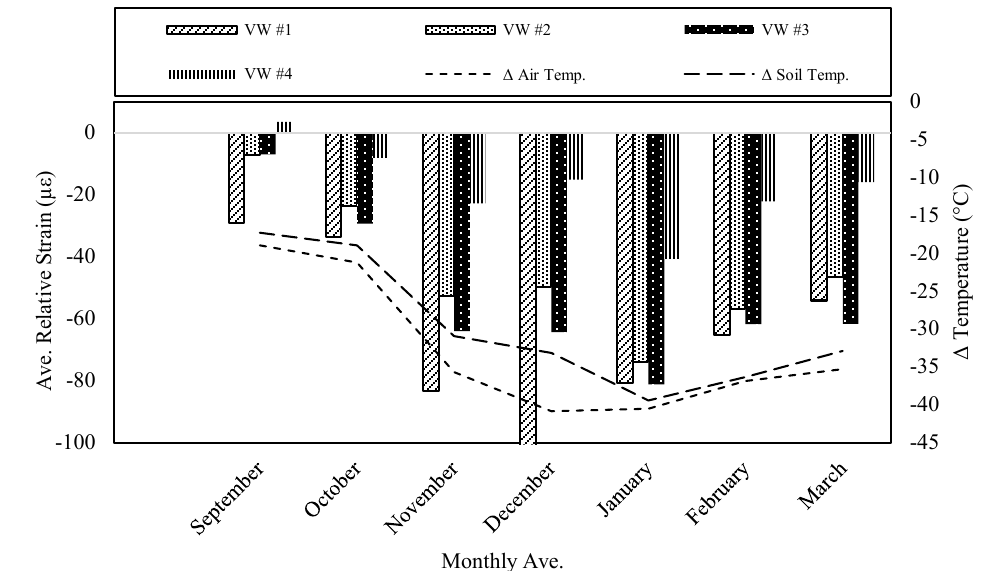
Figure 14. Strain Gauge Monthly Ave. Relative to Temperature.